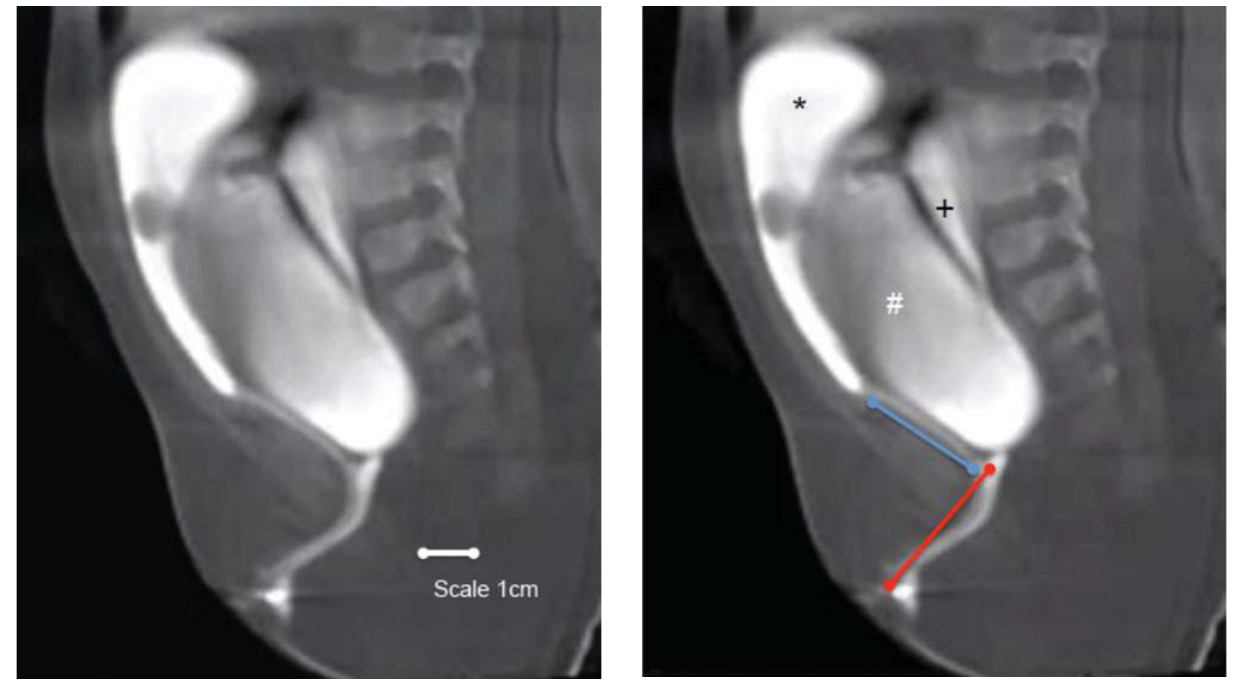
Fig. 1 Cloacagram (using water soluble contrast). Fig. 2 Common channel: 3 cm (red line); Urethra: 2.5 cm (blue line). ( (cid:1) ) Bladder, (#) Vagina, ( þ )